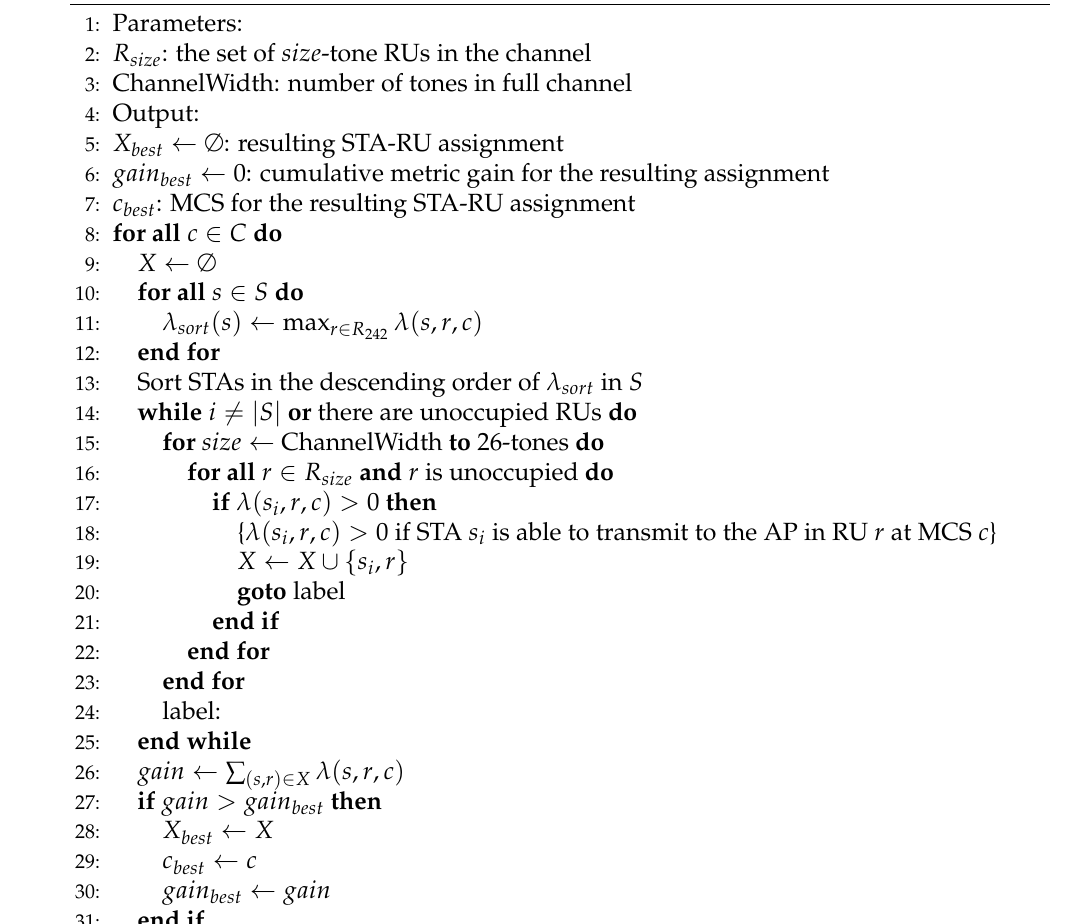
Algorithm 1 Greedy Scheduling